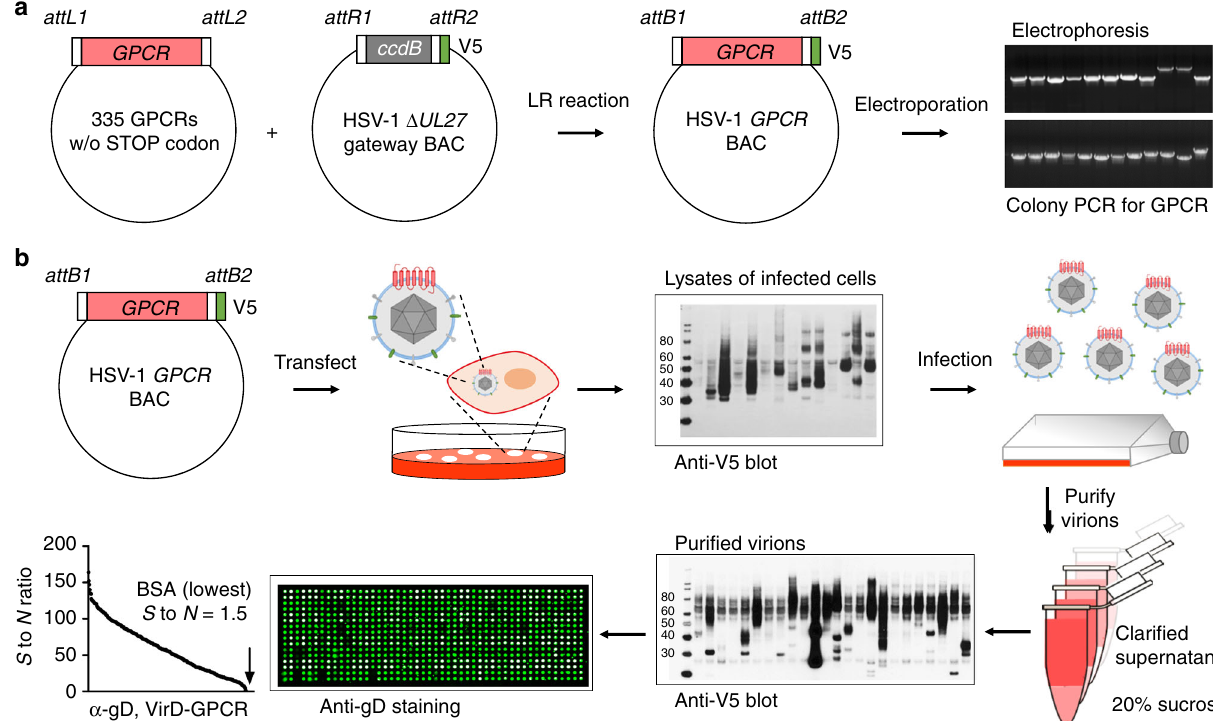
Fig. 1 Construction of high-content VirD-GPCR array. a Subcloning of 335 human GPCR ORFs into the UL27 locus of the HSV-1 genome. After the STOP codons were removed from the 335 available GPCR ORFs, they were subcloned into the UL27 locus in the HSV-1 genome on a BAC vector, resulting in fusion with a V5 tag at their C-termini (middle panel). After bacterial transformation, colony PCR reactions were carried out and the products examined using electrophoresis to identify the correct construct (right panel). b Production of VirD-GPCR virions and VirD array fabrication. Con fi rmed recombinant virus constructs were individually transfected to Vero cells and the viruses were harvested ~7 days post-transfection. Anti-V5 mAb was used to examine expression of the GPCRs as a quality control. Passers were next used to infect cells for virion production. After sucrose cushion centrifugation, a fraction